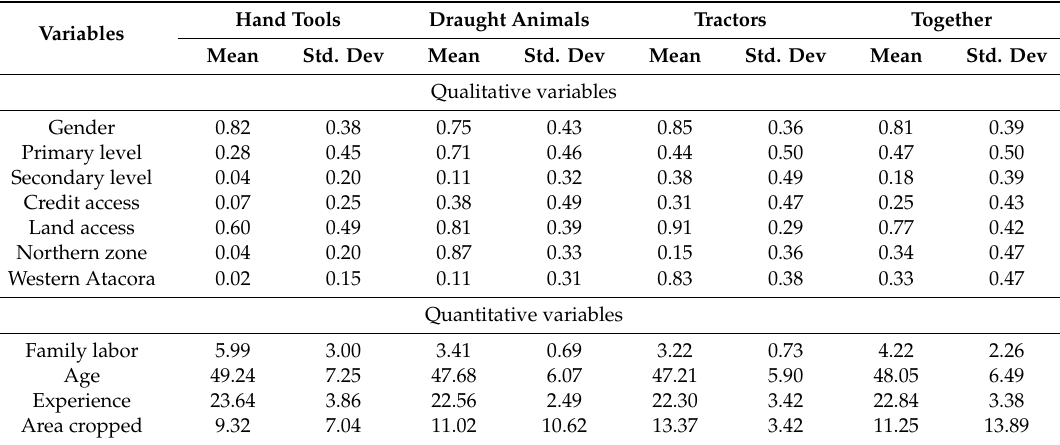
Table 2. Descriptive statistics of variables.